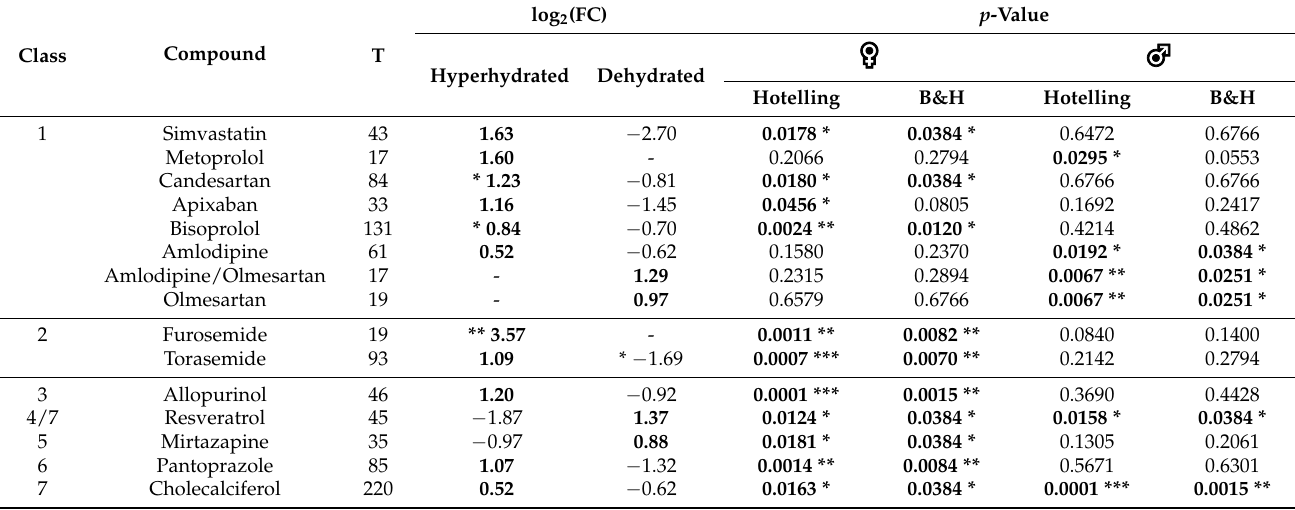
Table 2. Enriched medication in the dehydrated and hyperhydrated group.